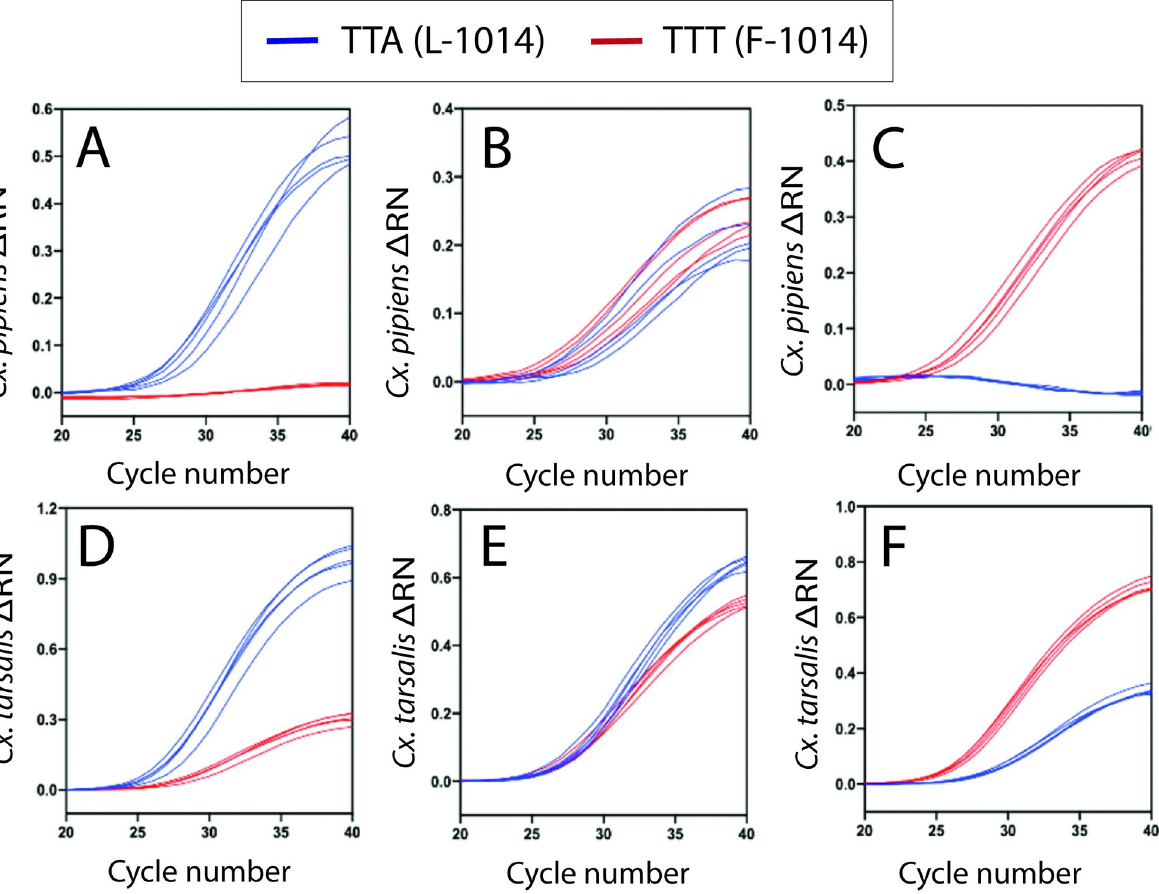
Fig 2. Amplification plots of the Culex RT kdr assay for adult Cx . pipiens and Cx . tarsalis captured in Alameda County using encephalitis vector survey traps. Amplification plots ( Δ RN vs Cycle Number) with the RT kdr _TTA probe labeled in blue and RT kdr _TTT probe in red. Genotype assignments based upon whether one or both probes amplified in a Culex RT kdr assay, and subsequently confirmed using Δ CT values (see Fig 3). (A) Culex pipiens homozygous LL-1014 (B) Culex pipiens heterozygous LF-1014 (C) Culex pipiens homozygous FF-1014 ( D) Culex tarsalis homozygous LL-1014 (E) Culex tarsalis heterozygous LF-1014 (F) Culex tarsalis homozygous